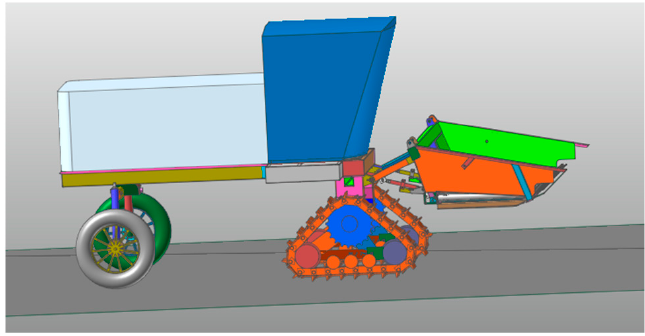
Figure 11. Three-dimensional model of a rape